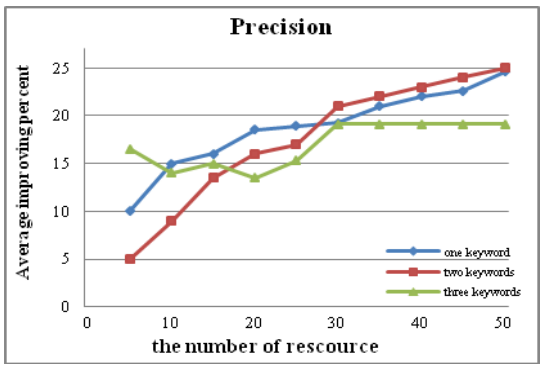
Fig 5. Precision comparison